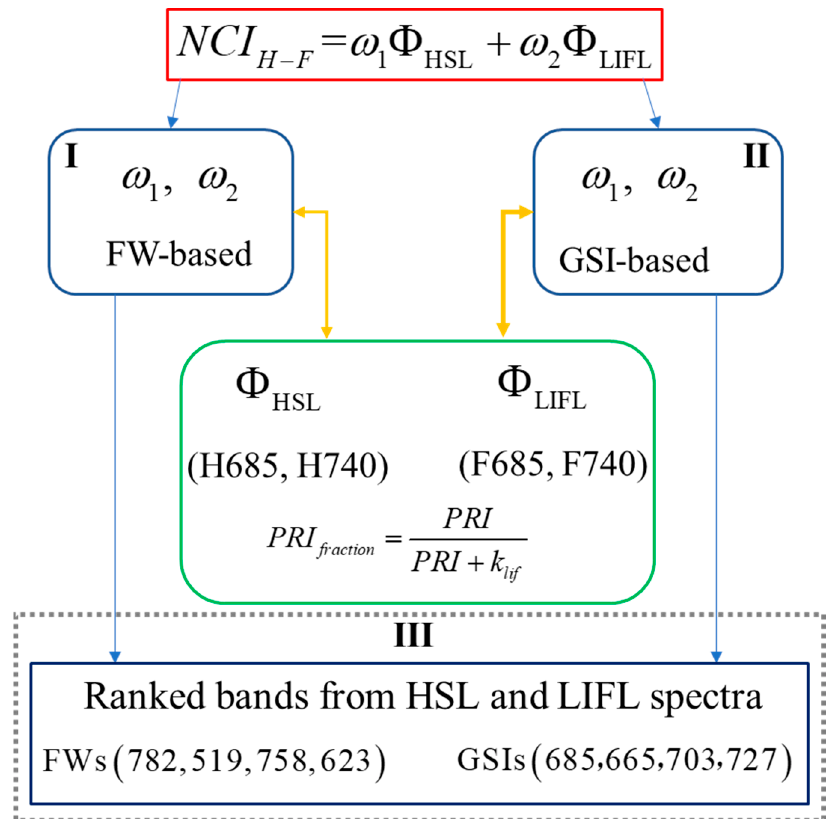
Figure 3. Overview of the analysis methods in this study.